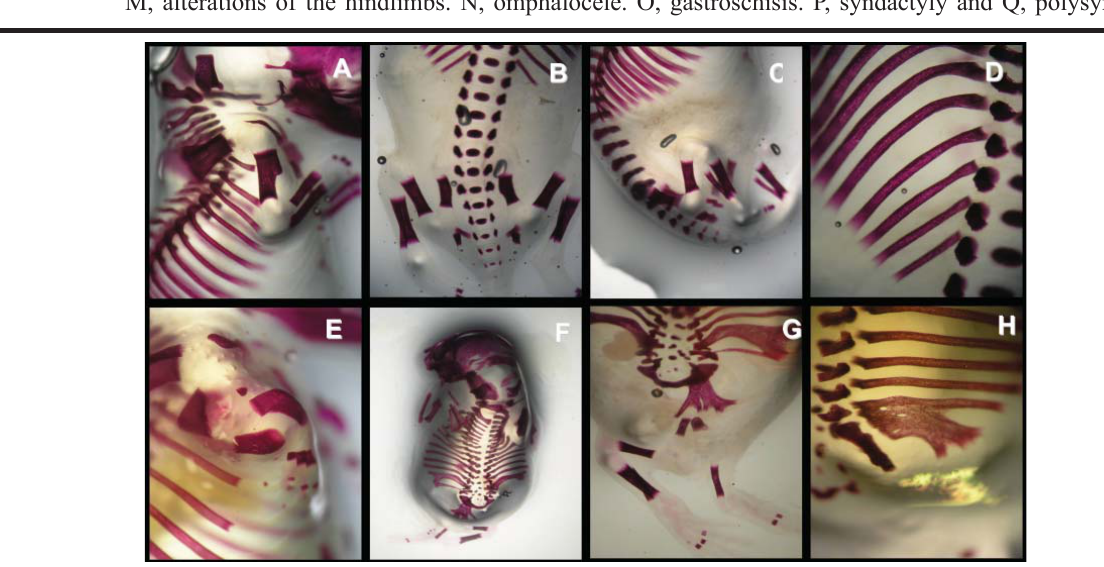
FIGURE 2 - Photographs of selected diaphanized fetuses. A, B, C and D re control fetuses. E, fetus with alterations of the forelimbs (rhizomesomelia); note the shortening compared to control. F and G have tail regression (pelvis hypoplasia and femur and fi bula agenesis). G and H have rib fusion (diaphanization technique and Alizarin